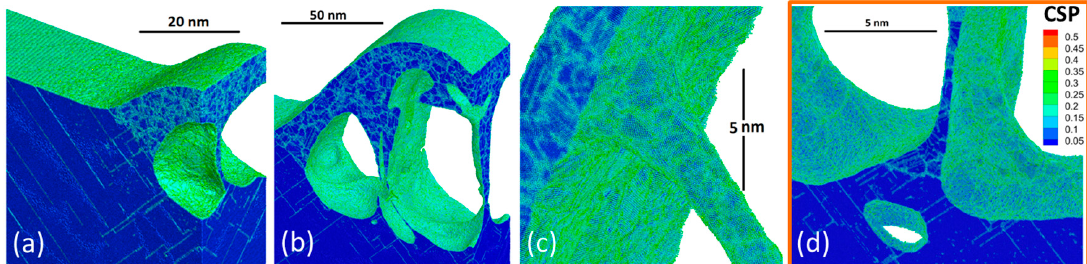
Figure 7. The nanostructures generated in the simulations on periodic nanostructuring are magnified for ( a ) the period of 270 nm at the incident fluence of 120 mJ / cm 2 and ( b ) 145 mJ / cm 2 . ( c ) Structures obtained for the case of a 500-nm period at the incident fluence of 160 mJ / cm 2 and ( d ) 250 mJ / cm 2 . The atoms are colored by CSP parameter.